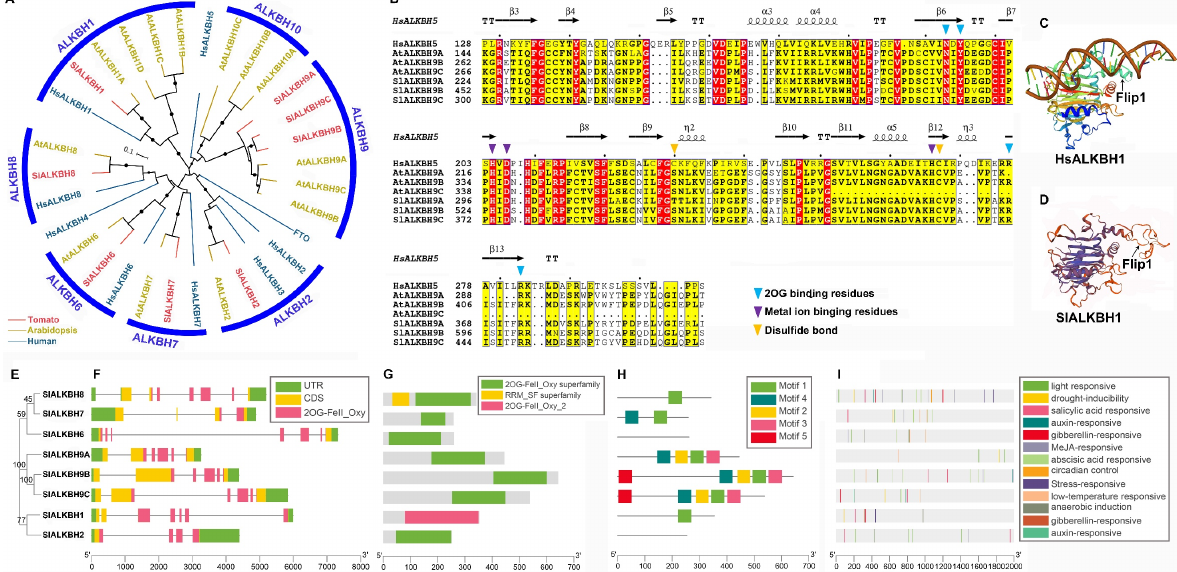
Figure 3. Evolutionary and structure analyses of the ALKBH family in tomato. ( A ) Phylogenetic tree of ALKBH family proteins from tomato, Arabidopsis , and human. ( B ) Sequence alignment of ALKBH9 subfamily proteins from tomato and Arabidopsis , and human HsALKBH5. The secondary structural elements in the HsALKBH5 (PDB: 4nj4) 2OG_Fe(II)_Oxy domain are shown above. The colored triangles indicate key functional residues in human. ( C , D ) Three-dimensional structures of HsALKBH1 (PDB: 6ie2) and SlALKBH1. ( E ) Phylogenetic tree of ALKBH family proteins in tomato. ( F ) Gene structure analysis. The coding sequence (CDS), untranslated region (UTR), and 2OG_Fe(II)_Oxy domain are displayed in different colors, and the lines between boxes represent introns. ( G , H ) Conserved domain and motif analysis. ( I ) Locations of cis-elements in the 2 kb promoter sequences.